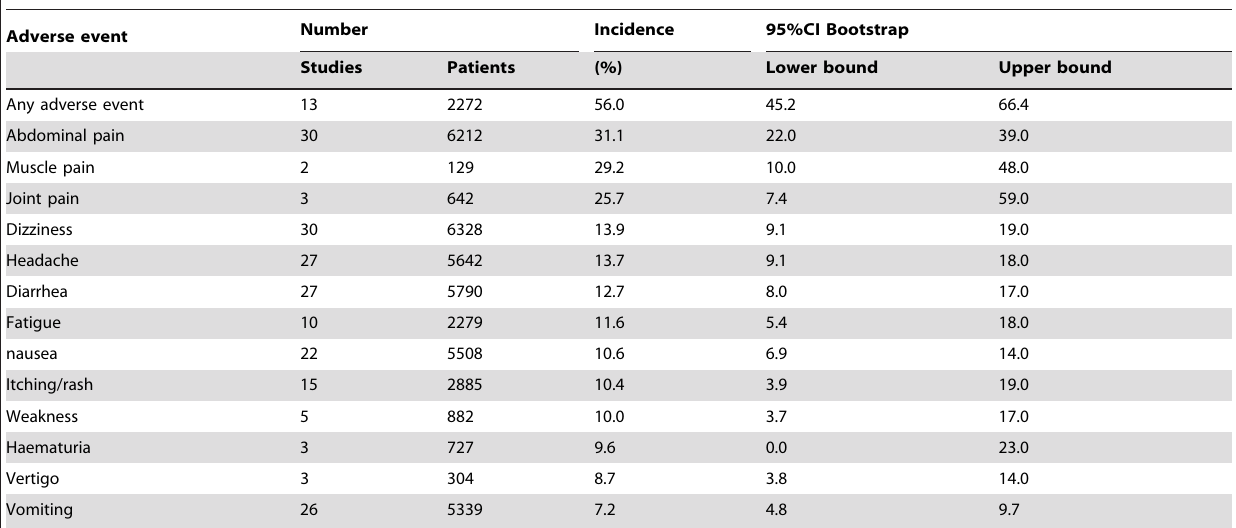
Table 3. Adverse event incidence, praziquantel 40